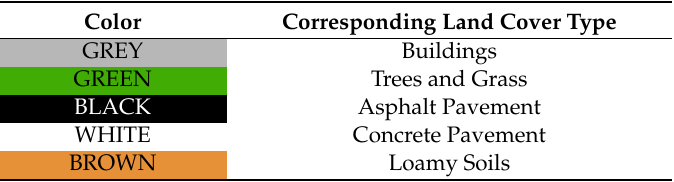
Table 2. Color key for ENVI-met input files shown in Figure